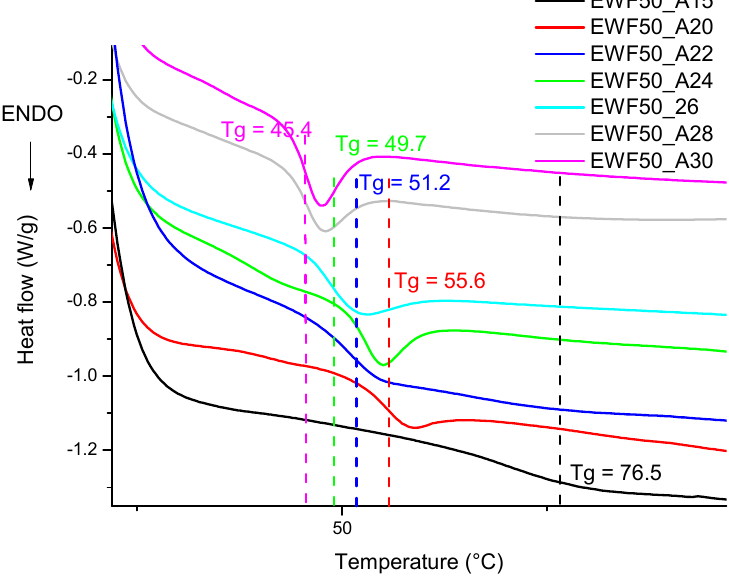
Figure 7. DSC analysis of postcured blends at different amine contents .